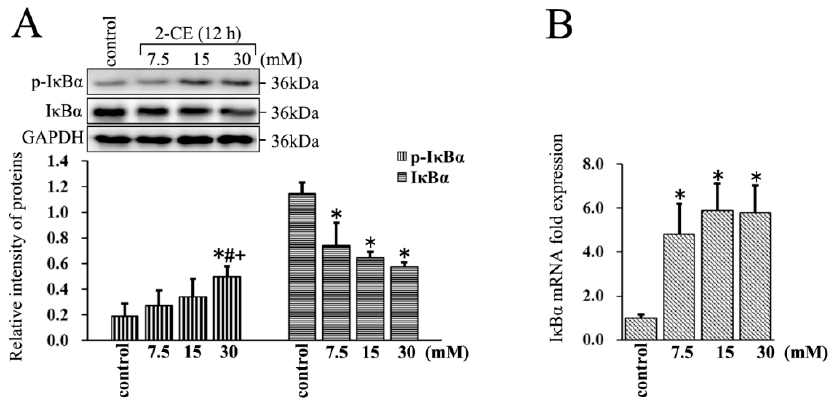
Figure 3. The phosphorylation of I κ B α affected by 2-CE in astrocytes. ( A , B ) Astrocytes were treated with 0, 7.5, 15, and 30 mM 2-CE for 12 h; ( A ) The levels of p-inhibitor of κ B α (I κ B α ) and I κ B α in astrocytes measured by Western blotting; ( B ) The I κ B α mRNA levels analyzed by RT-PCR. ( n = 4; mean ± SD; * p < 0.05 vs. control group, # p < 0.05 vs. 7.5 mM of 2-CE, + p < 0.05 vs. 15 mM of 2-CE; one-way ANOVA followed by SNK tests.).